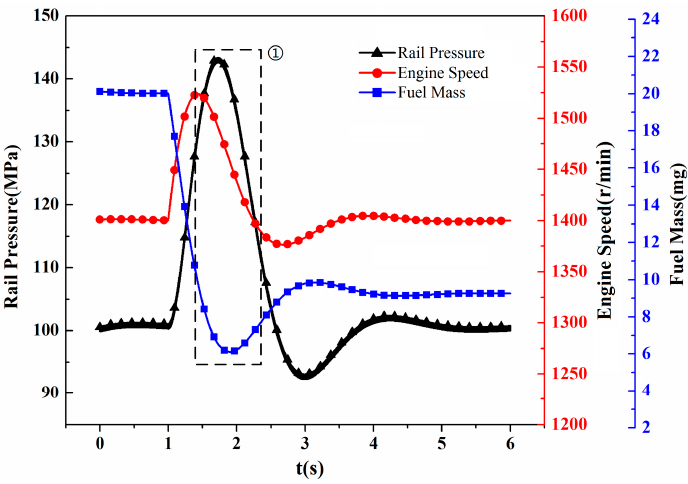
Figure 11. Rail pressure, engine speed and fuel mass vs. time controlled by PID.